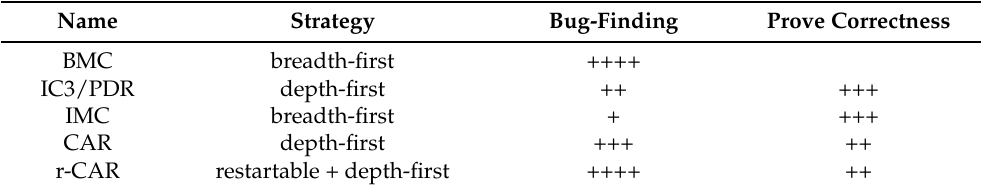
Table 1. Modern model checking